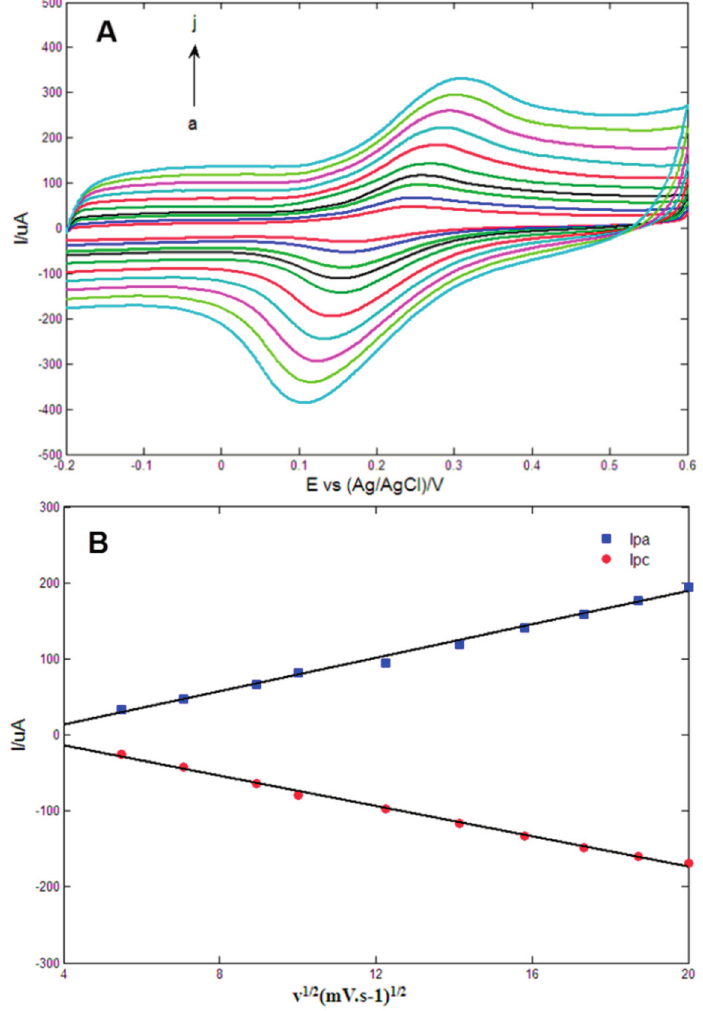
Figure 6. ( A ) Cyclic voltammetrys of Au1Pt1NPs-GR/GCE in 0.1 M PBS (pH = 7.0) containing 0.2 mM dopamine at 30, 50, 80, 100, 150, 200, 250, 300, 350 and 400 mV/s (from a to j ); ( B ) Plots of anodic ( I pa ) and cathodic peak currents ( I pc ) vs. scan